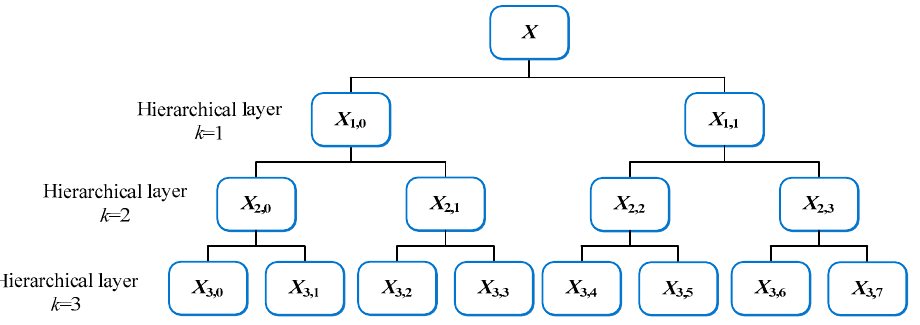
Figure 3. The structure of hierarchical components with three hierarchical layers. (cid:8) (cid:9) x ( i ) , i = 1, 2, · · · , N (1) For an arbitrary time series X , the averaging operator Q 0 and di ff